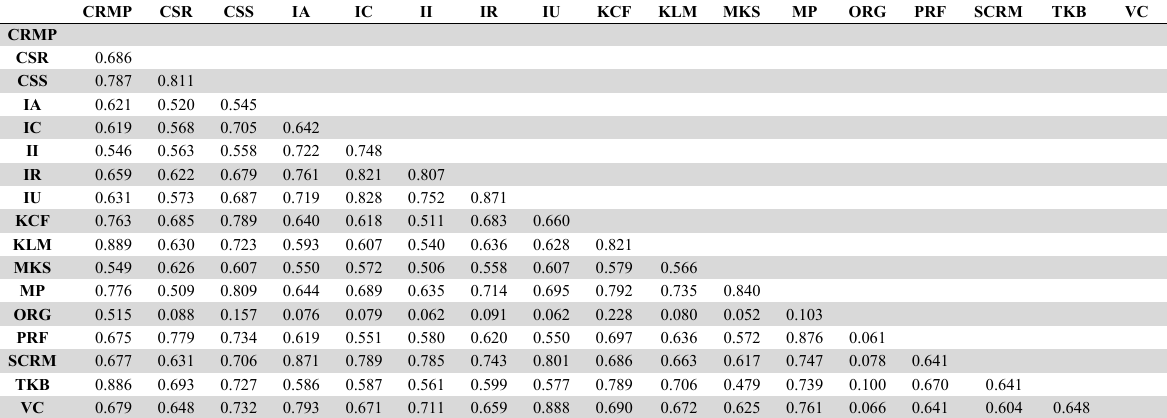
Discriminant Validity